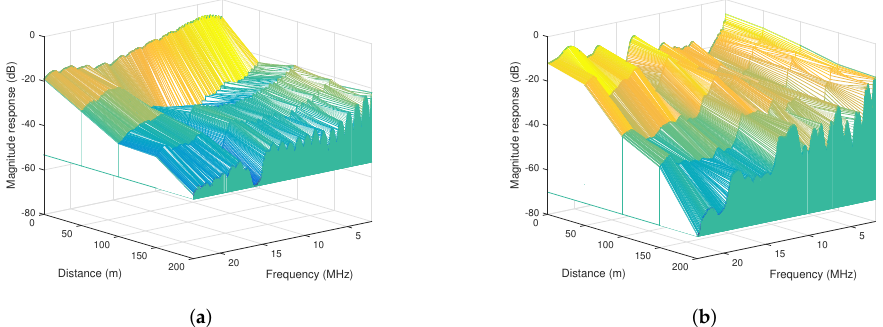
Figure 5. Magnitude response | H ( f k ) | of the PLC channel at various distances from (2). ( a ) Overhead power line. ( b ) Underground power